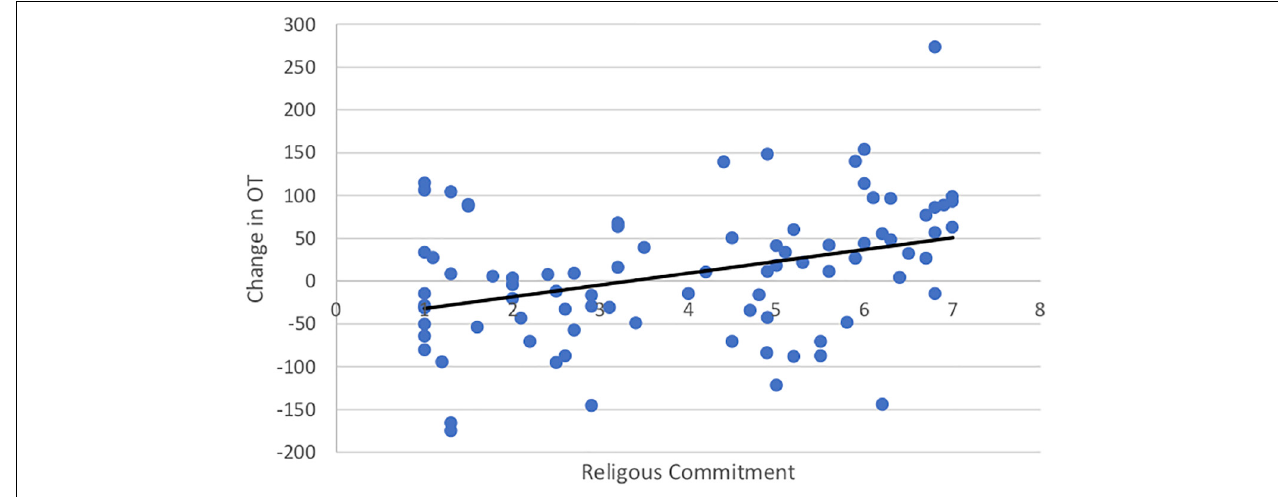
FIGURE 6 | Positive correlation between religious commitment and change in